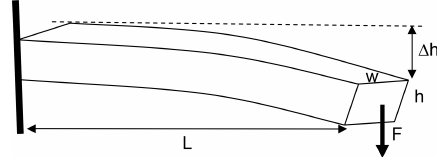
Figure 5. Bending of a bar. When a given force F is applied as shown, the amount of bending (cid:49)h is proportional to L 3 , 1 /h 2 , and 1 /w . Scaling all three quantities by the same factor leads to (cid:49)h (at a given force) being independent of L